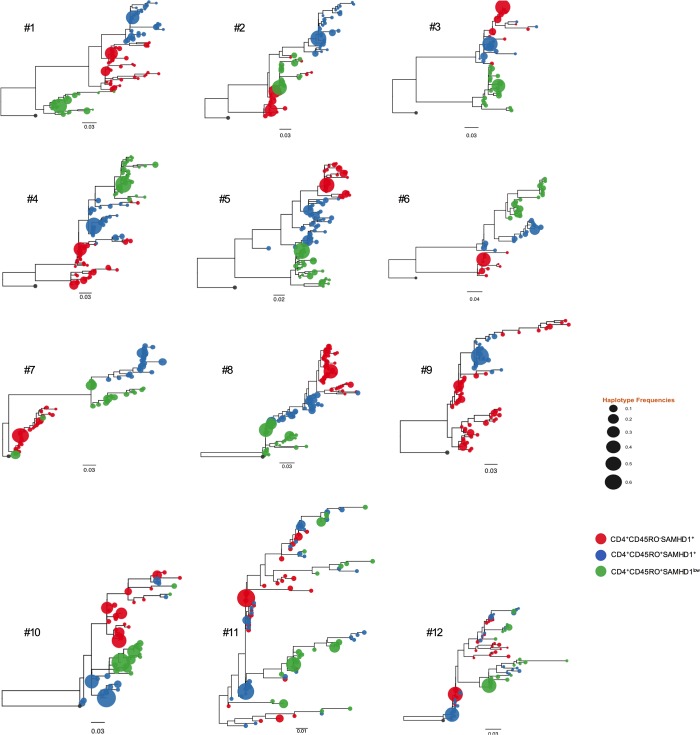
Distinct/well-segregated HIV-1 DNA populations in both memory CD4+ CD45RO+ SAMHD1low, CD4+ CD45RO+ SAMHD1+ and naive CD4+ CD45RO- SAMHD1+ subsets.Ultra-deep-sequencing (UDS, 454/Roche) of partial env (C2/V3) HIV-1 DNA (n = 12 HIV-1 infected individuals receiving c-ART) was performed. Neighbor-joining phylogenetic trees representing compartmentalized and equilibrated viral populations in 10 patients out of 12 studied patients. Genetic distance is indicated with a scale bar (number of nucleotide substitutions per site). Shown are results for the 12 individuals. HIV haplotypes were extracted from reads covering partial env; env sequences from naive CD4+CD45RO-SAMHD1+, memory CD4+CD45RO+SAMHD1+ and CD4+CD45RO+SAMHD1low are depicted in red, blue, and green, respectively. Tip size is proportional to variant frequency. Scale bars are in substitutions/site.